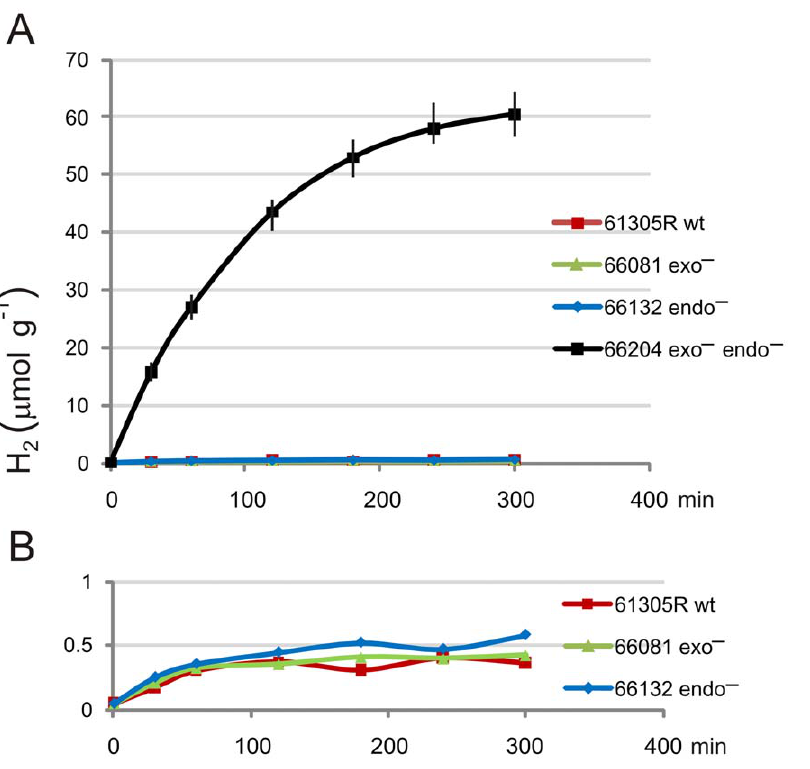
Figure 1. Hydrogen (H 2 ) evolution by excised S.rostrata stem nodules elicited by indicated A.caulinodans strains as endosymbiont. (A) 70 m mol scale; (B) expanded ordinate, 1 m mol scale; evolved H 2 measured as m mol g 2 1 (fresh biomass).